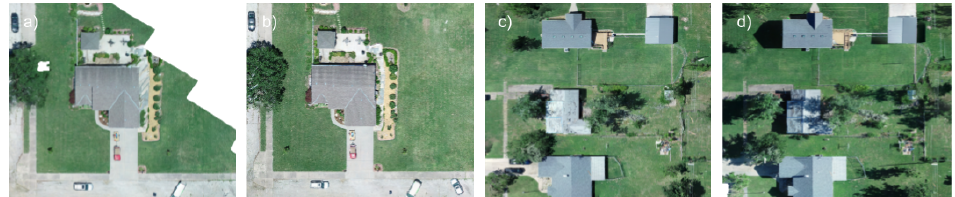
Figure A1. Orthomosaic samples on overlap areas: ( a ) 101, ( b ) 102, ( c ) 103, and ( d ) 104. Many features distinguish Figure A1a,b from two orthomosaics at the same location: (1) there is no car at the right bottom corner in Figure A1a; (2) the right side of the building in Figure A1a is distorted at the edge of SfM orthomosaic; (3) the color in Figure A1a is slightly cooler; and (4) the right top corner in Figure A1a is blank because of SfM. The different shadows between Figure A1c,d show the changing lighting